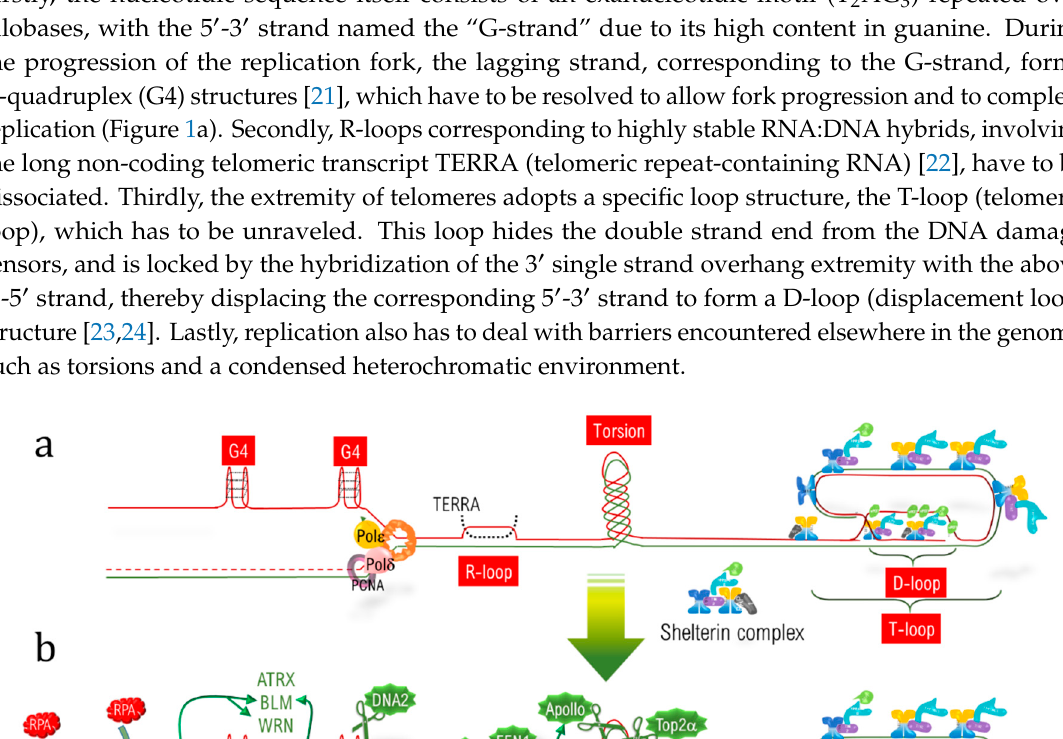
Figure 1. Obstacles and solutions to replicate telomeres. ( a ) Telomeric sequence, with the G-strand in solid red line and the C-strand in solid green line, is depicted. The terminal D-loop structuring the much larger T-loop is stabilized by the shelterin complex. The replisome (PCNA, Pol ε , Pol δ ... ) polymerizes a new G-strand (depicted in dotted red line) and frees the parental G-strand, enabling the formation of G4. R-loops corresponding to TERRA hybridization (in dotted black lines) with the 3 ′ -5 ′ strand, and torsions due to the fork progression are also shown. ( b ) Replication helpers, such as helicases (ATRX, BLM, WRN, RTEL1, and RECQL4), either helping in G4 unwinding or in D-loop unlocking, are depicted. The DNAses (Top2a, DNA2) and RNAses (RNAse H1 and FEN1) help in resolving torsions and RNA:DNA heteroduplexes, while Timeless stimulates the replisome. POT1 competes with RPA1 for binding of the single-strand and helps in G4 dissolution. The shelterin components POT1, TRF1 and TRF2 help in loading the helper-proteins (fine green arrows).